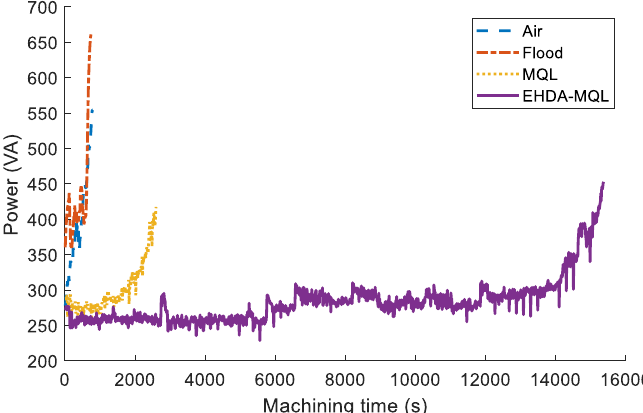
Figure 6. Power consumption for material cutting for various cooling-lubrication systems.